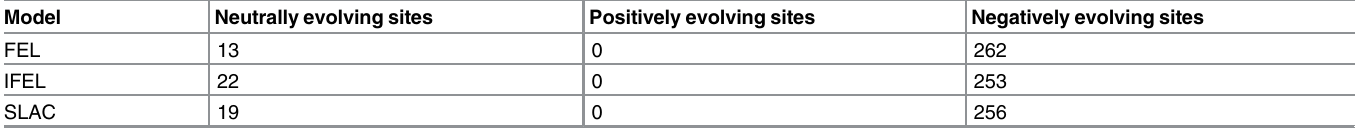
Table 2. Positive selection analysis of the STK domain of Pto-like genes from various plants.